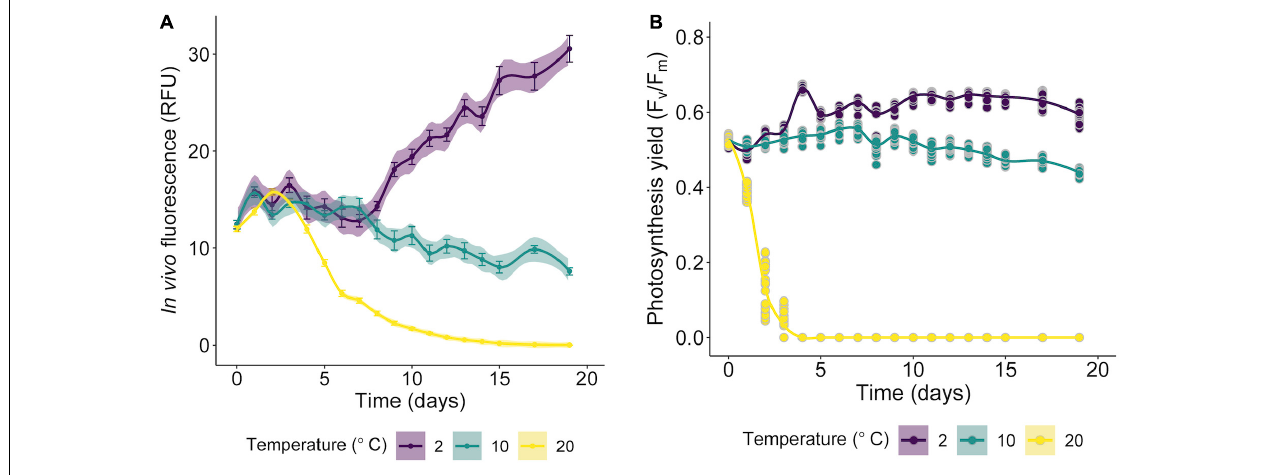
FIGURE 7 | Growth curves of Chlorominima collina CCAP 6/1 based on RFU values (A) and efficiency of the quantum yield of photosystem II (PSII) (F v /F m ) (B) exposed to 2, 10, and 20 ◦ C. The lines show the trends, and the shading indicates the confidence intervals (CI). In the RFU graphs, each point is the mean of 24 replicates and the bars represent the standard error (SE). For F v /F m data, each point is an average of 24 replicates (raw data).